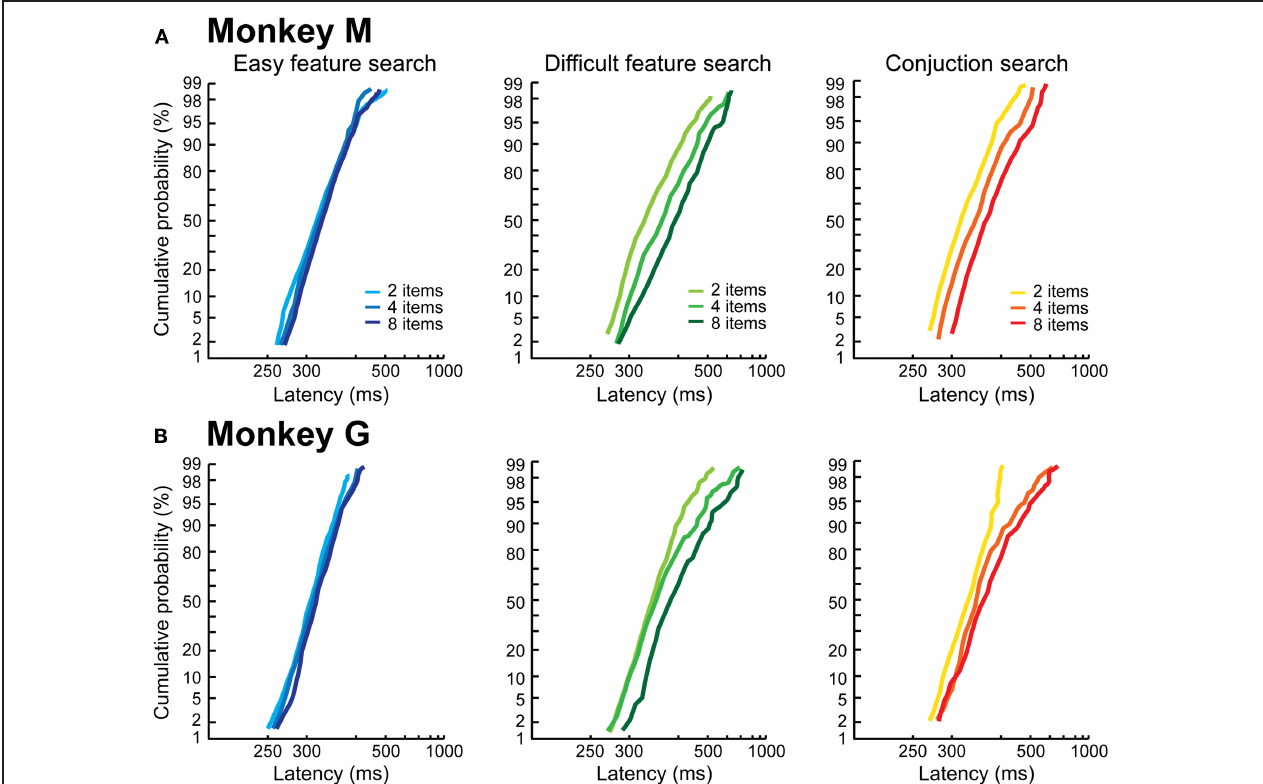
FIGURE 3 | Control reaction time distributions as a function of the search condition. The distributions are plotted as reciprobits, as a function of the number of items, in Monkey M (A) and Monkey G (B)